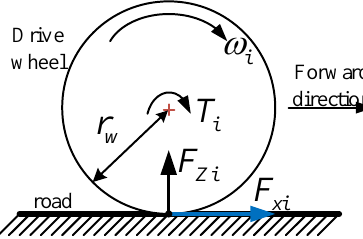
Figure 6. Wheel rotation dynamic model.